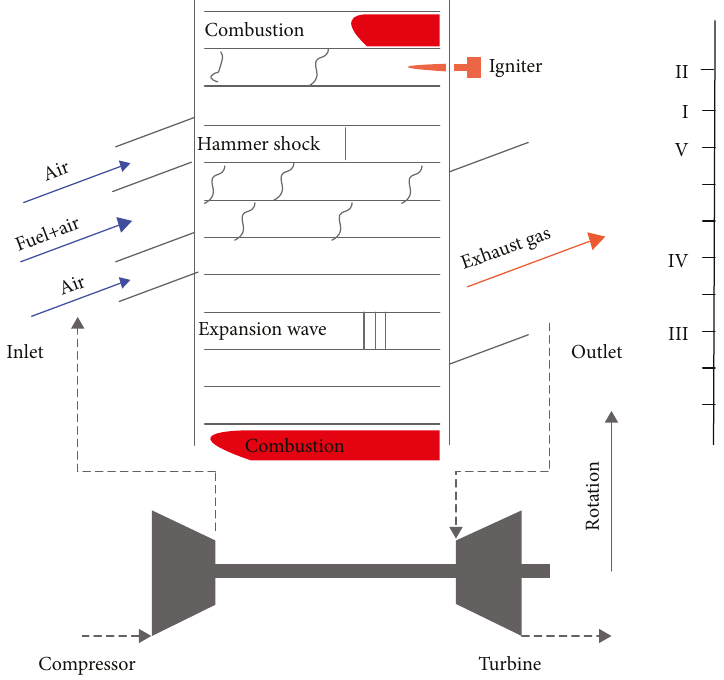
Figure 2: The schematic of the operating process for a